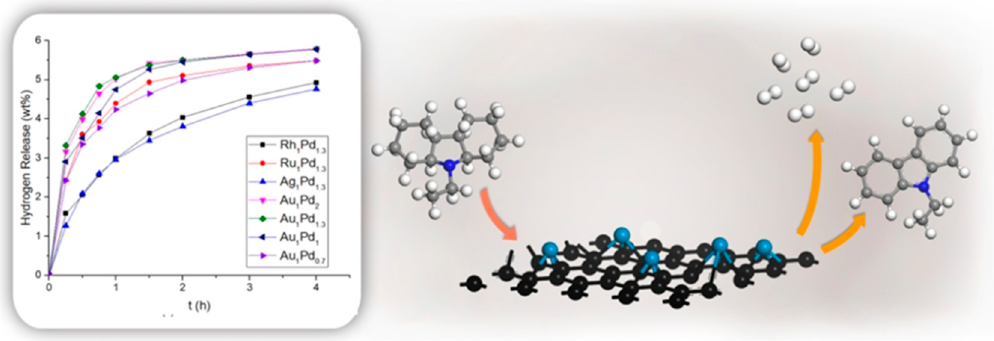
Figure 6. Hydrogen release amount for 12H-NEC on different catalysts over time at 453 K; copyright (2018), ACS Sustainable Chemistry & Engineering.